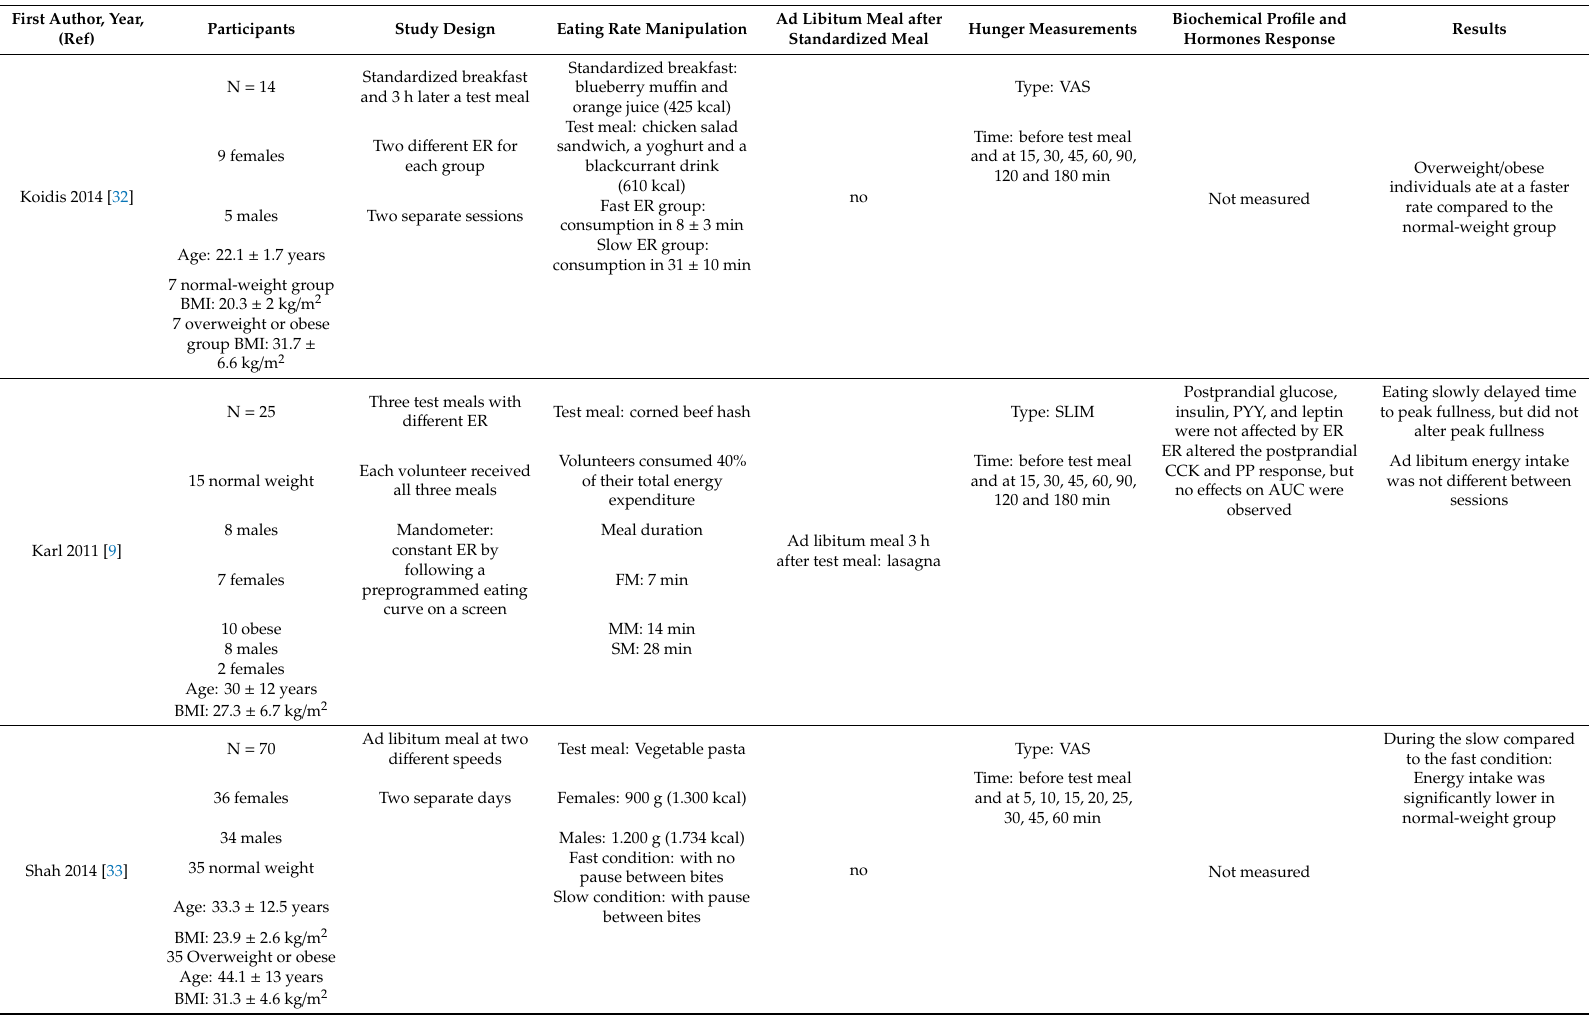
Table 2. Studies examining the e ff ect of manipulating eating rate and mastication speed in patients with overweight /